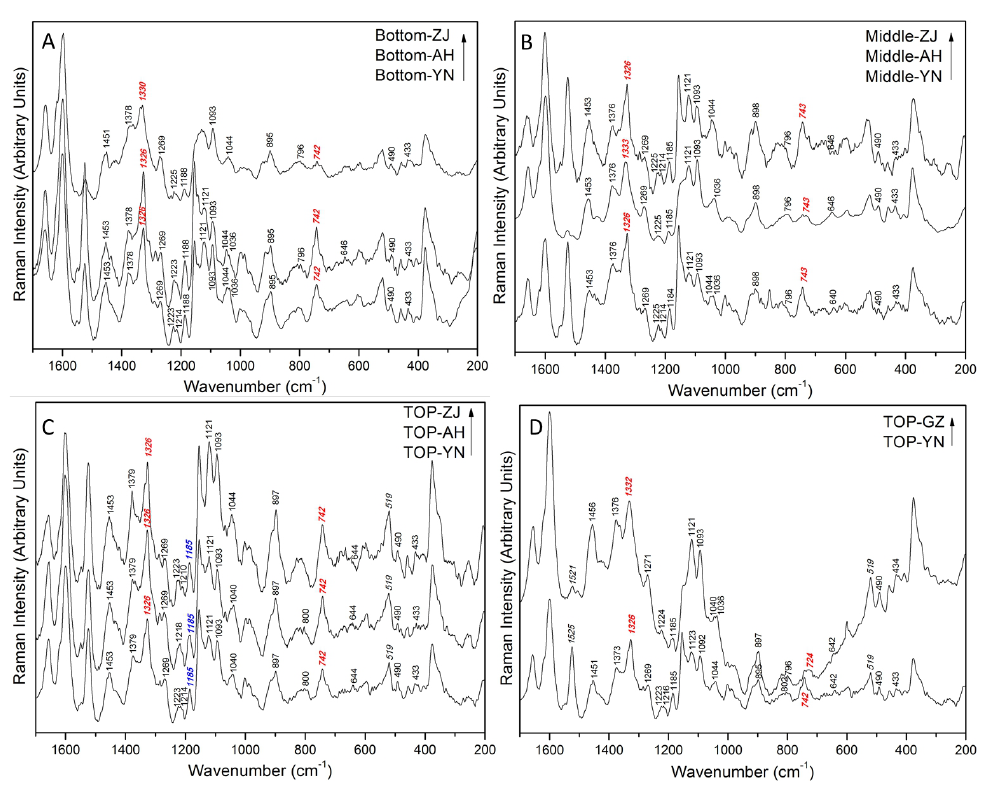
Figure 4 (A–D) Raman spectra of top/middle/bottom stem from Dendrobium of different origins. Full-size DOI: